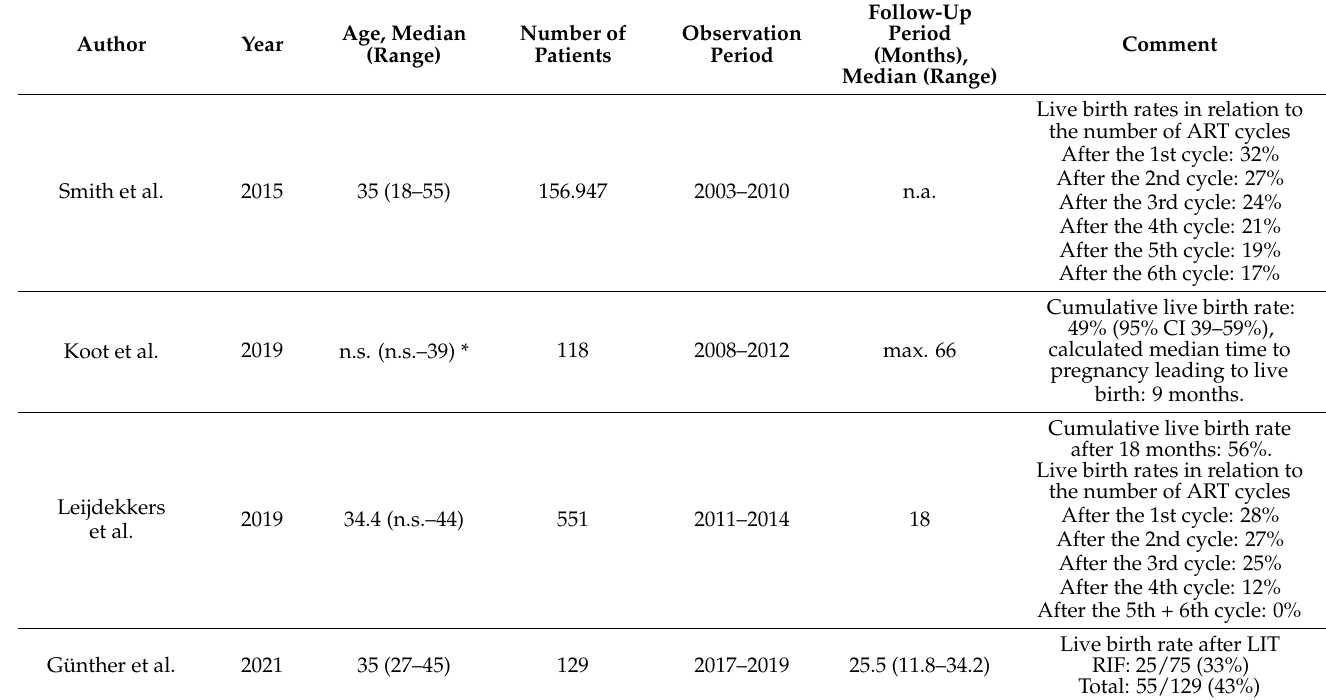
Table 3. Summary of selected studies on live birth rates in RIF patients without additional treatment compared to live birth rates after LIT in our